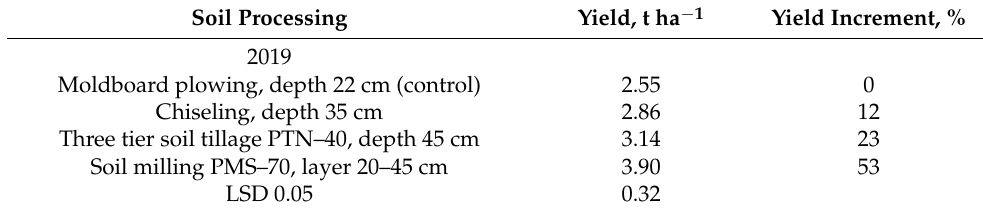
Table 9. Spring barley yield after different options of soil mechanical